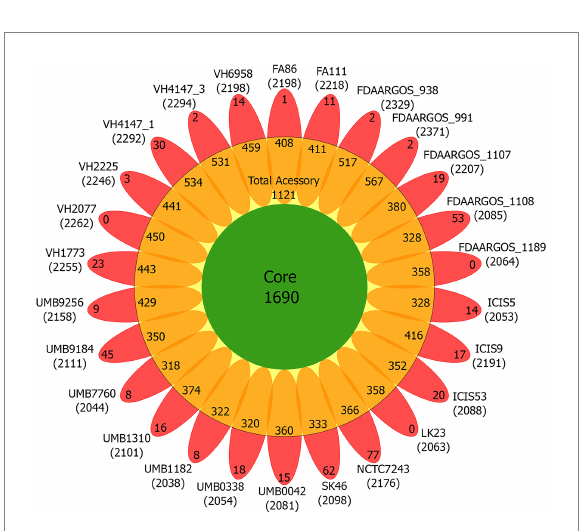
FIGURE 3 Flower plot diagram of the C. amycolatum pan-genome, showing core gene families (green), accessory genes present in each isolate (orange), and unique genes per genome (red). Within parentheses are the numbers of predicted coding sequences for each